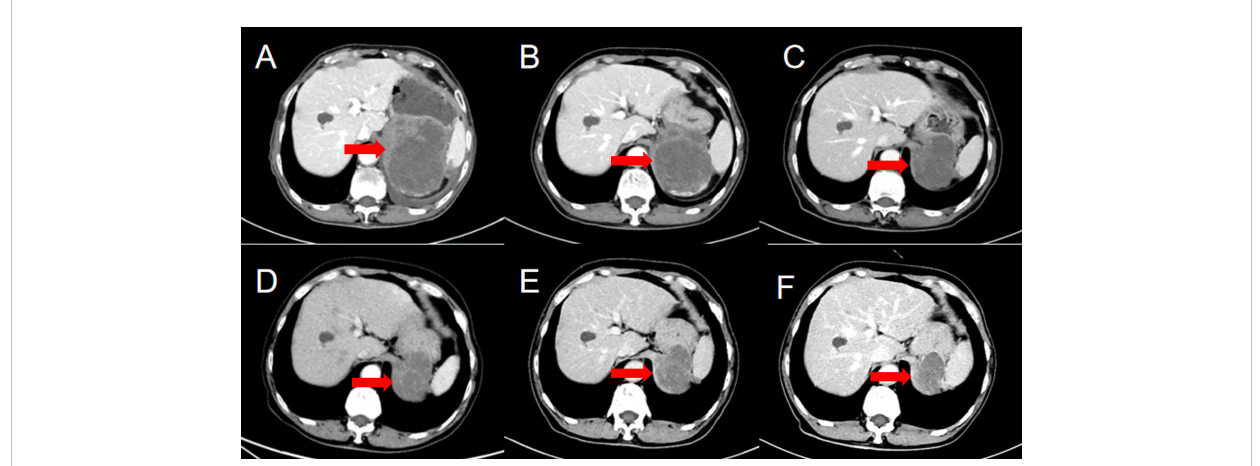
FIGURE 3 Computed tomography images before and after treatment. Review after immunotherapy showed signi fi cant reduction in the sizes of the left adrenal region. The time of CT was (A) 2021-07-30, (B) 2021-09-13, (C) 2021-11-30, (D) 2022-02-20, (E) 2022-05-12, (F)